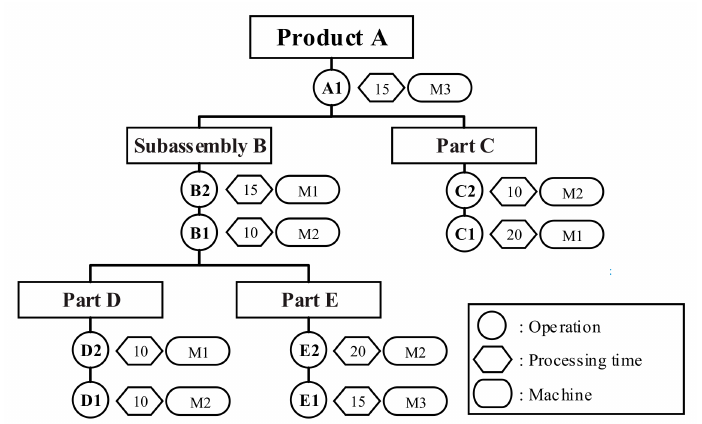
Figure 1. Tree-like assembly structure of product